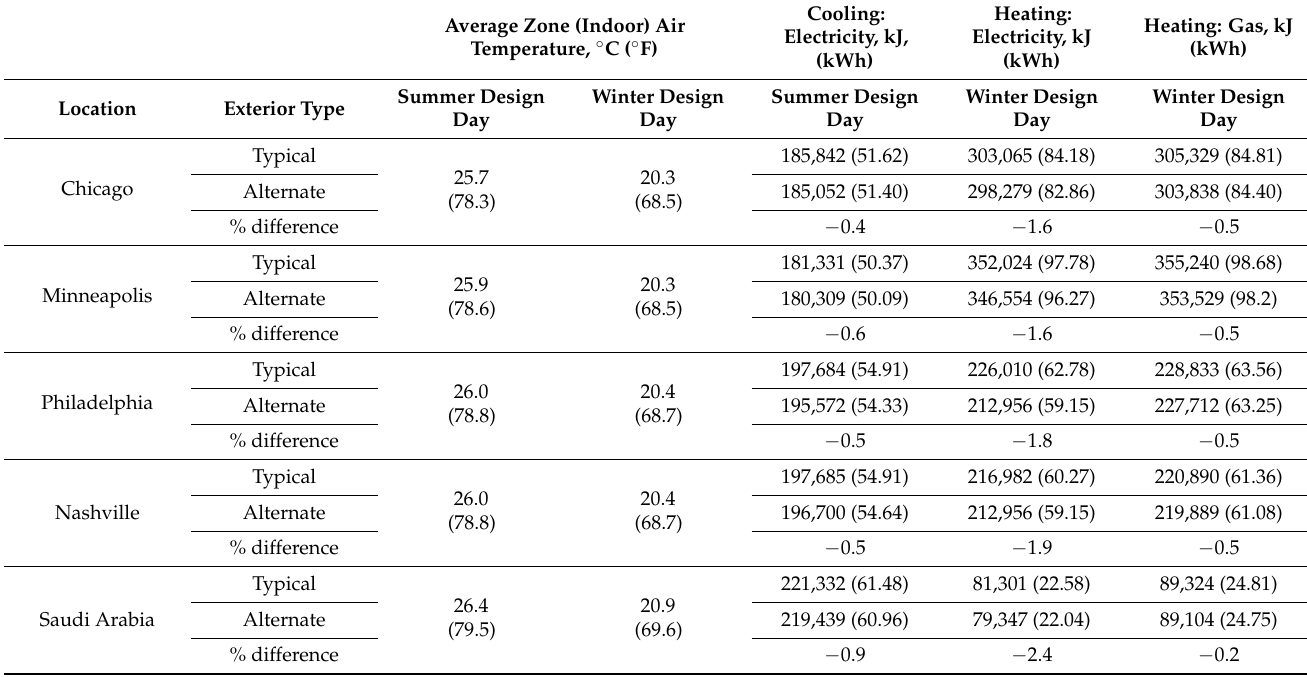
Table 11. Results for small hotel reference model building energy simulations.